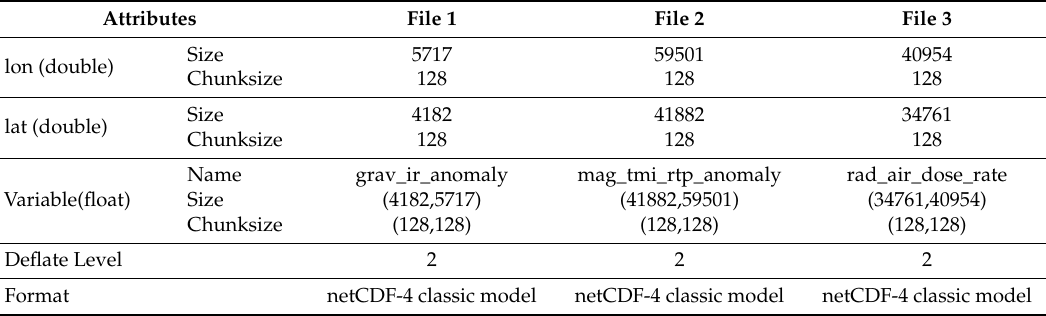
Table 3. Data structure of the sample files used in the benchmark